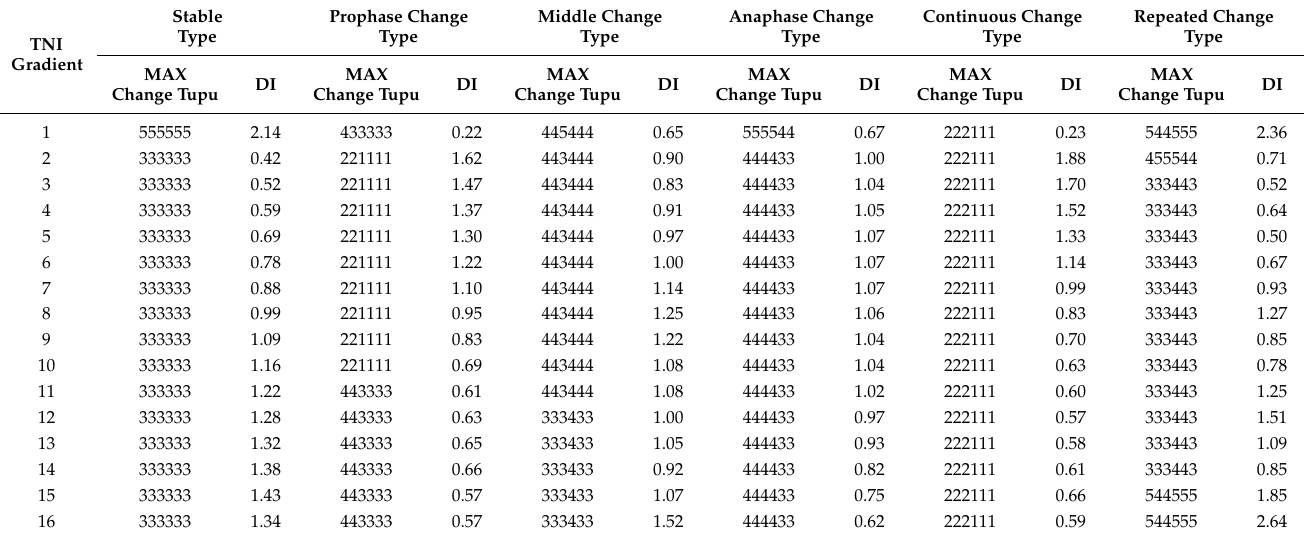
Table 3. The distribution index of LER maximum change Tupu with different terrain